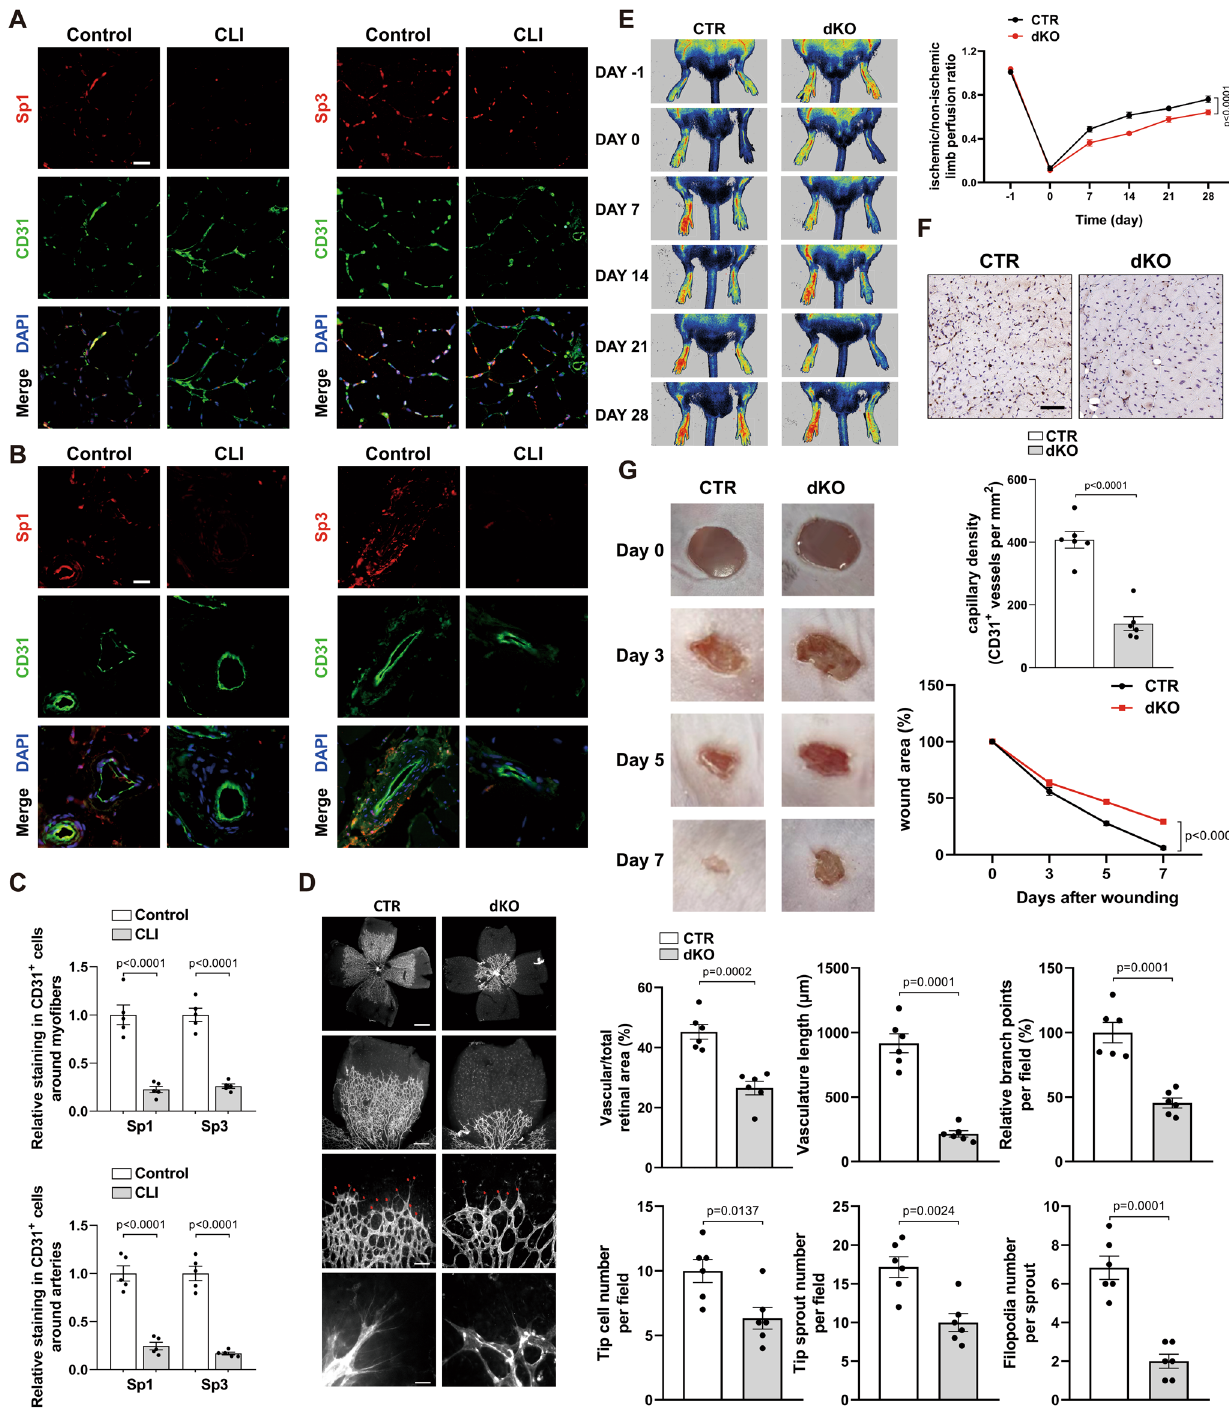
Fig. 1 | Knockout of Sp1/Sp3 in ECs decreases angiogenesis in vivo. A , B Representativeimmuno fl uorescencestainingofSp1andSp3ingastrocnemius muscle biopsies of patients with critical limb ischemia (CLI) compared to healthy subjects. CD31 is an endothelial cell marker. Scale bar: 20 μ m. C Quanti fi cation of immuno fl uorescence staining of Sp1 and Sp3 in A and B . n =5. D Retinal whole- mountstainingofisolectin-B4inP5 VE-CAD-CreER T2- /Sp1 fl / fl /Sp3 fl / fl (CTR)and VE-CAD- CreER T2+ /Sp1 fl / fl /Sp3 fl / fl (dKO) mice. Red arrowheads show tip cell sprouting and fi lopodia. Right, quanti fi cation of vascular/total retinal area, vasculature length, branch points per fi eld, tip cell number per fi eld, tip sprout number per fi eld, and fi lopodia number per sprout. Scale bars: 500 (row 1), 100 (row 2), 50 (row 3), and 10 μ m(row4). n =6. E RepresentativelaserDopplerimagesofthelegsacquiredon days – 1 (before surgery), 0 (immediately after surgery), 7, 14, 21, and 28 after